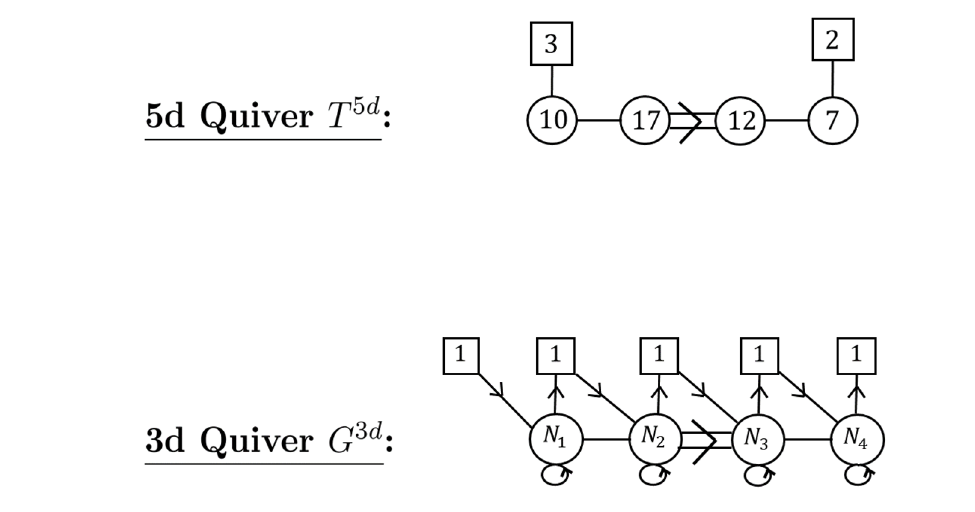
Figure 8. Sphere with 3 full F 4 punctures: 5d theory T 5d and 3d theory G 3d resulting from W S